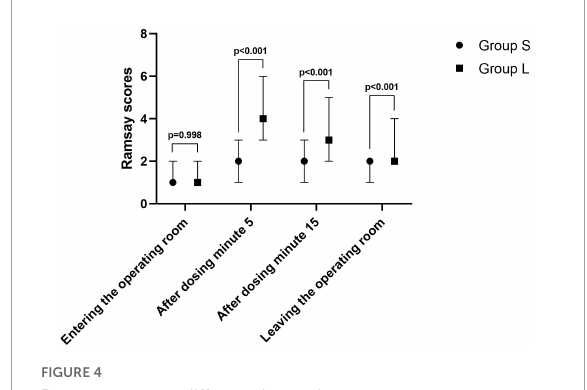
FIGURE4 Ramsay scores at different time